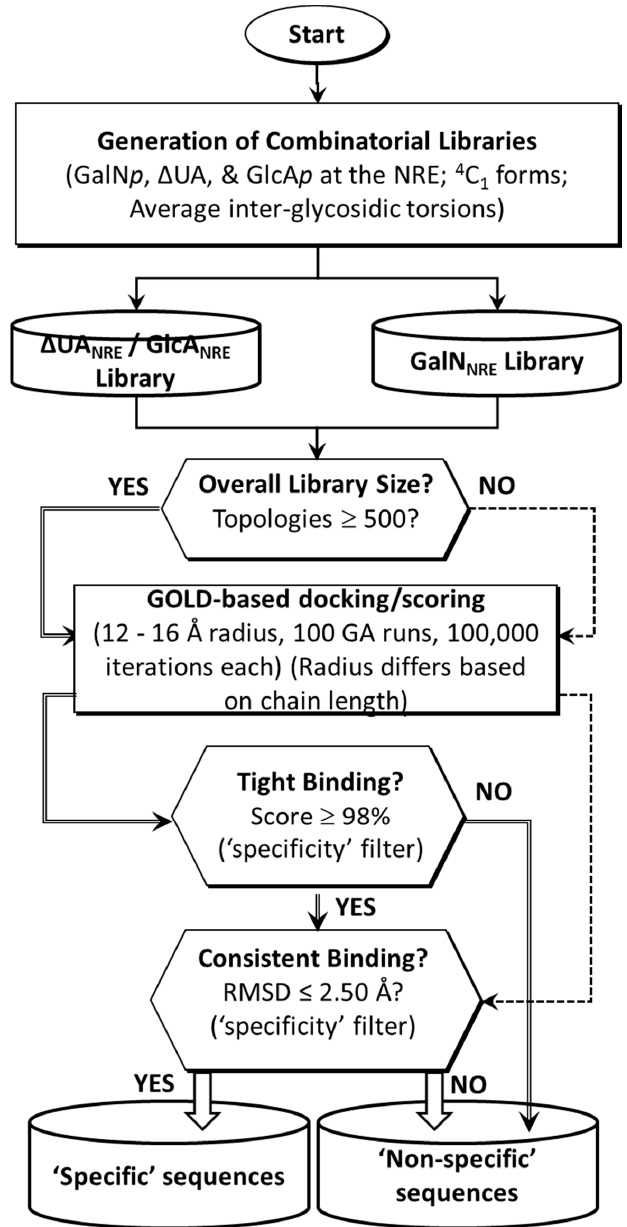
Figure 1. Combinatorial virtual library screening (CVLS) protocol used to study the TGF- β 2–CS interaction. The CVLS protocol assessed the interaction of the CS02, CS04, and CS06 sequences using a dual-filter strategy that relied on GOLDScore and geometric convergence (RMSD) filters to assess the selectivity of binding.